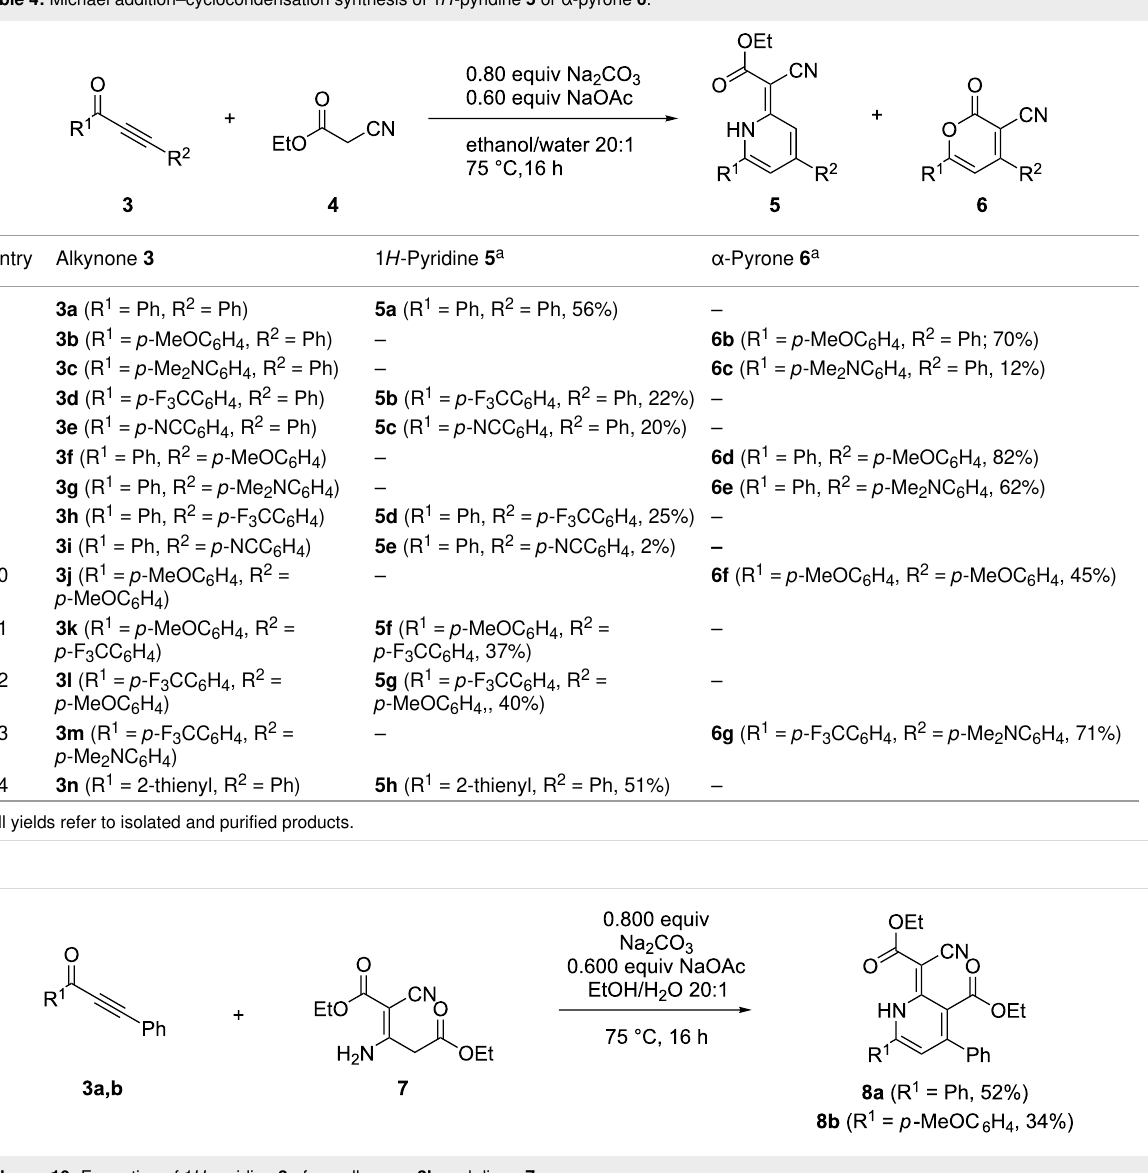
Table 4: Michael addition–cyclocondensation synthesis of 1 H -pyridine 5 or α -pyrone 6 .